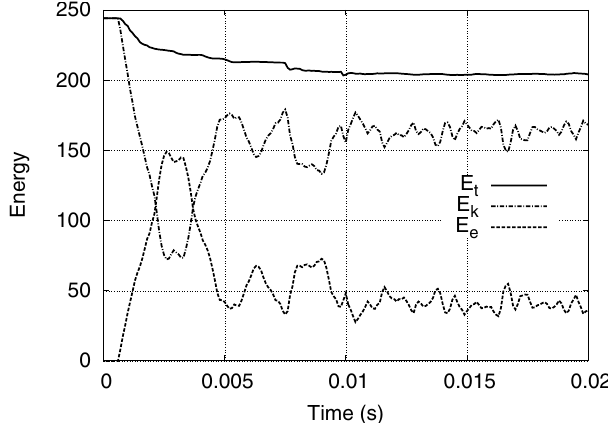
Fig. 8. Energy evolution vs.